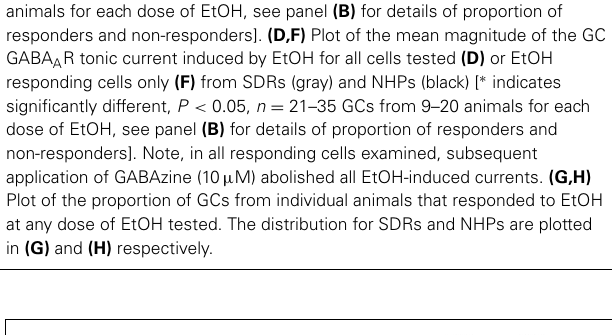
FIGURE 3 | EtOH enhancement of GC sIPSC frequency and tonic GABA A R current magnitude is restricted and variable in NHPs. (A) Representative data showing that EtOH can either increase sIPSC frequency (insets) and potentiate the tonic GABA A R current magnitude (main trace left panel) or have no impact on tonic GABA A R currents (right panel) or sIPSC frequency (not shown) in NHP GCs. (B) Plot of proportion of GCs showing potentiation or no effect of EtOH on tonic GABA A R currents and sIPSC frequency in SDR (right, gray) and NHP (left, black) GCs. (C,E) Plot of the mean percent increase in sIPSC frequency induced by EtOH for all cells tested (C) or EtOH responding cells only (E) from SDRs (gray) and NHPs (black) [ ∗ indicates significantly different, P < 0 . 05, n = 21–35 GCs from 9–20